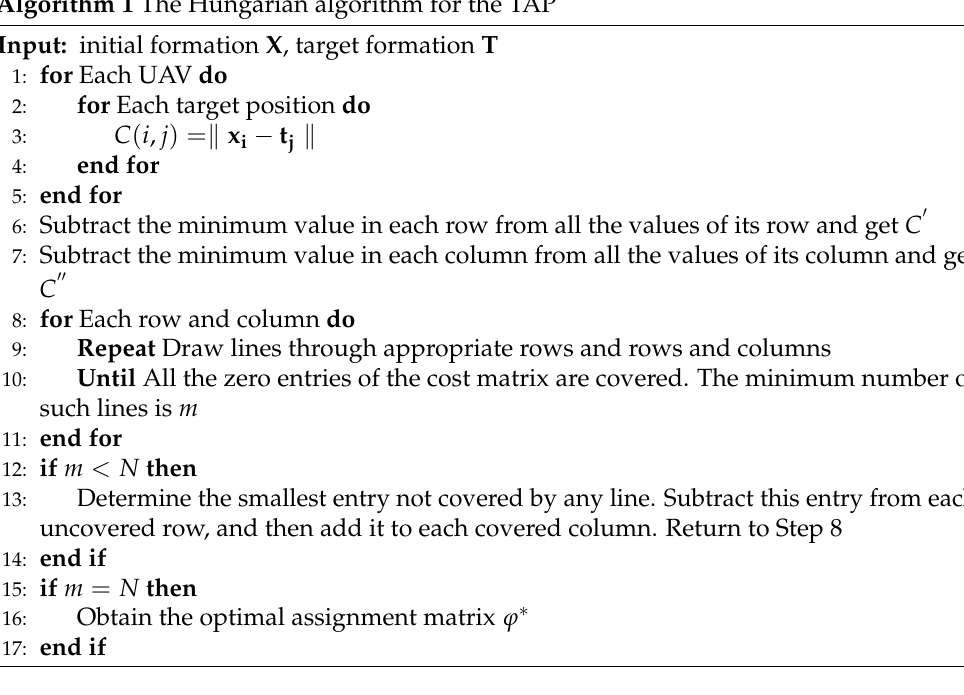
Algorithm 1 The Hungarian algorithm for the